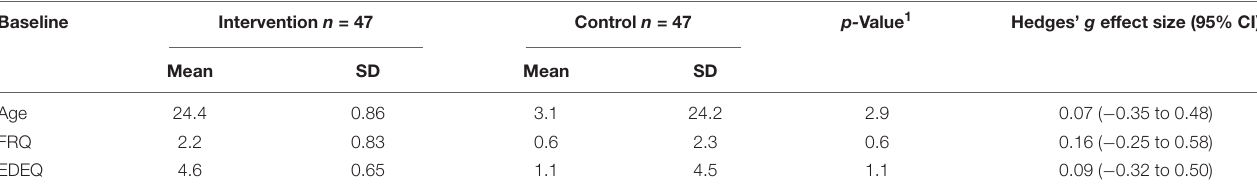
TABLE 1 | Baseline values of age, FRQ and EDEQ in both groups (means, SD, p , effect size, and 95% CI). Baseline